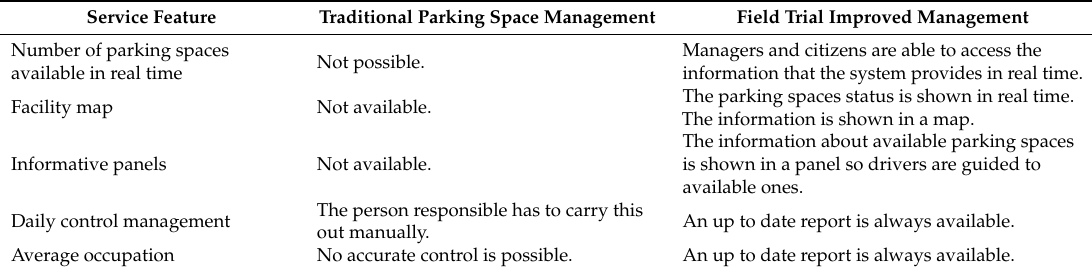
Table 2. IoT-based parking lot management compared to the traditional